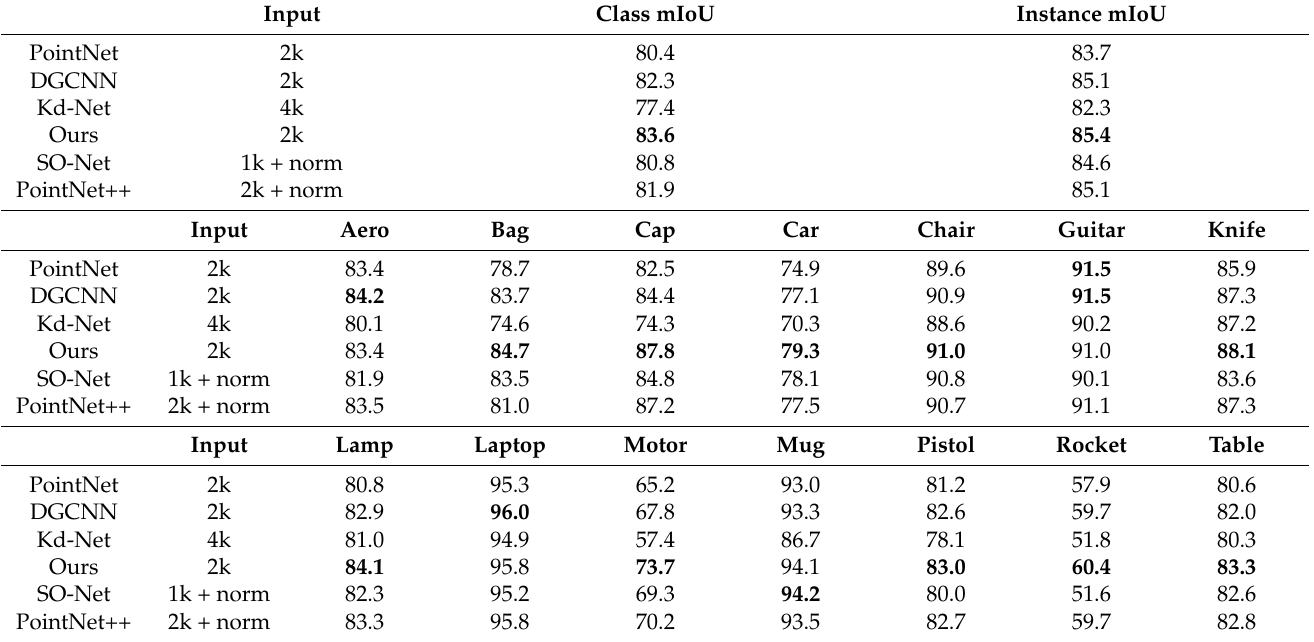
Table 2. Shape part segmentation IoU results (%) on the ShapeNet dataset. The best results are marked in bold.